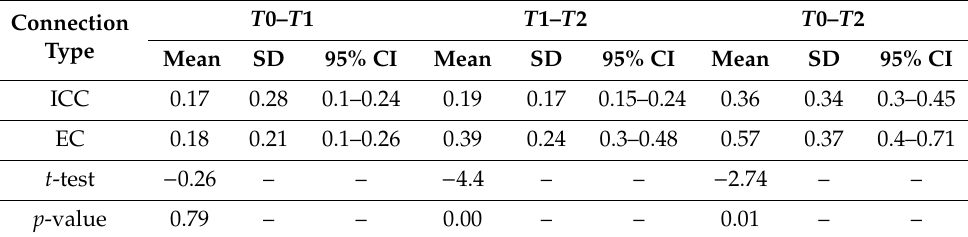
Table 2. Bone loss in internal and external